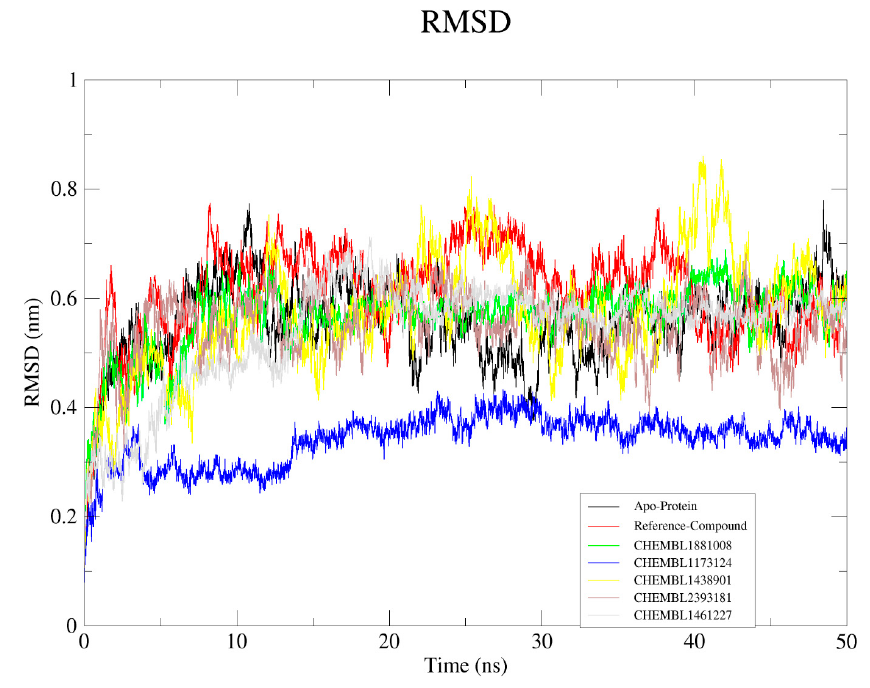
Figure 4. The RMSD graph of all complexes along with apo-protein during 50 ns MD Simulation.